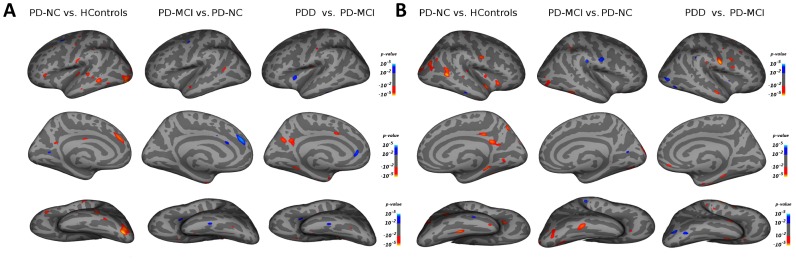
Cortical areas with significant cortical thickness changes between cognitive groups (p<0.01).Red areas show areas of decreased cortical thickness, and blue areas regions with increased cortical thickness. 1A: Left hemisphere; 1B: Right Hemisphere.